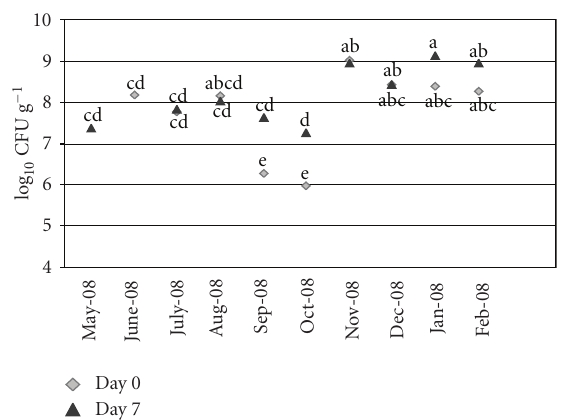
Figure 4: Lactic acid bacteria counts on MRS medium during the sampling period May 2008–February 2009. Values with letters in common are not statistically significant ( P < .